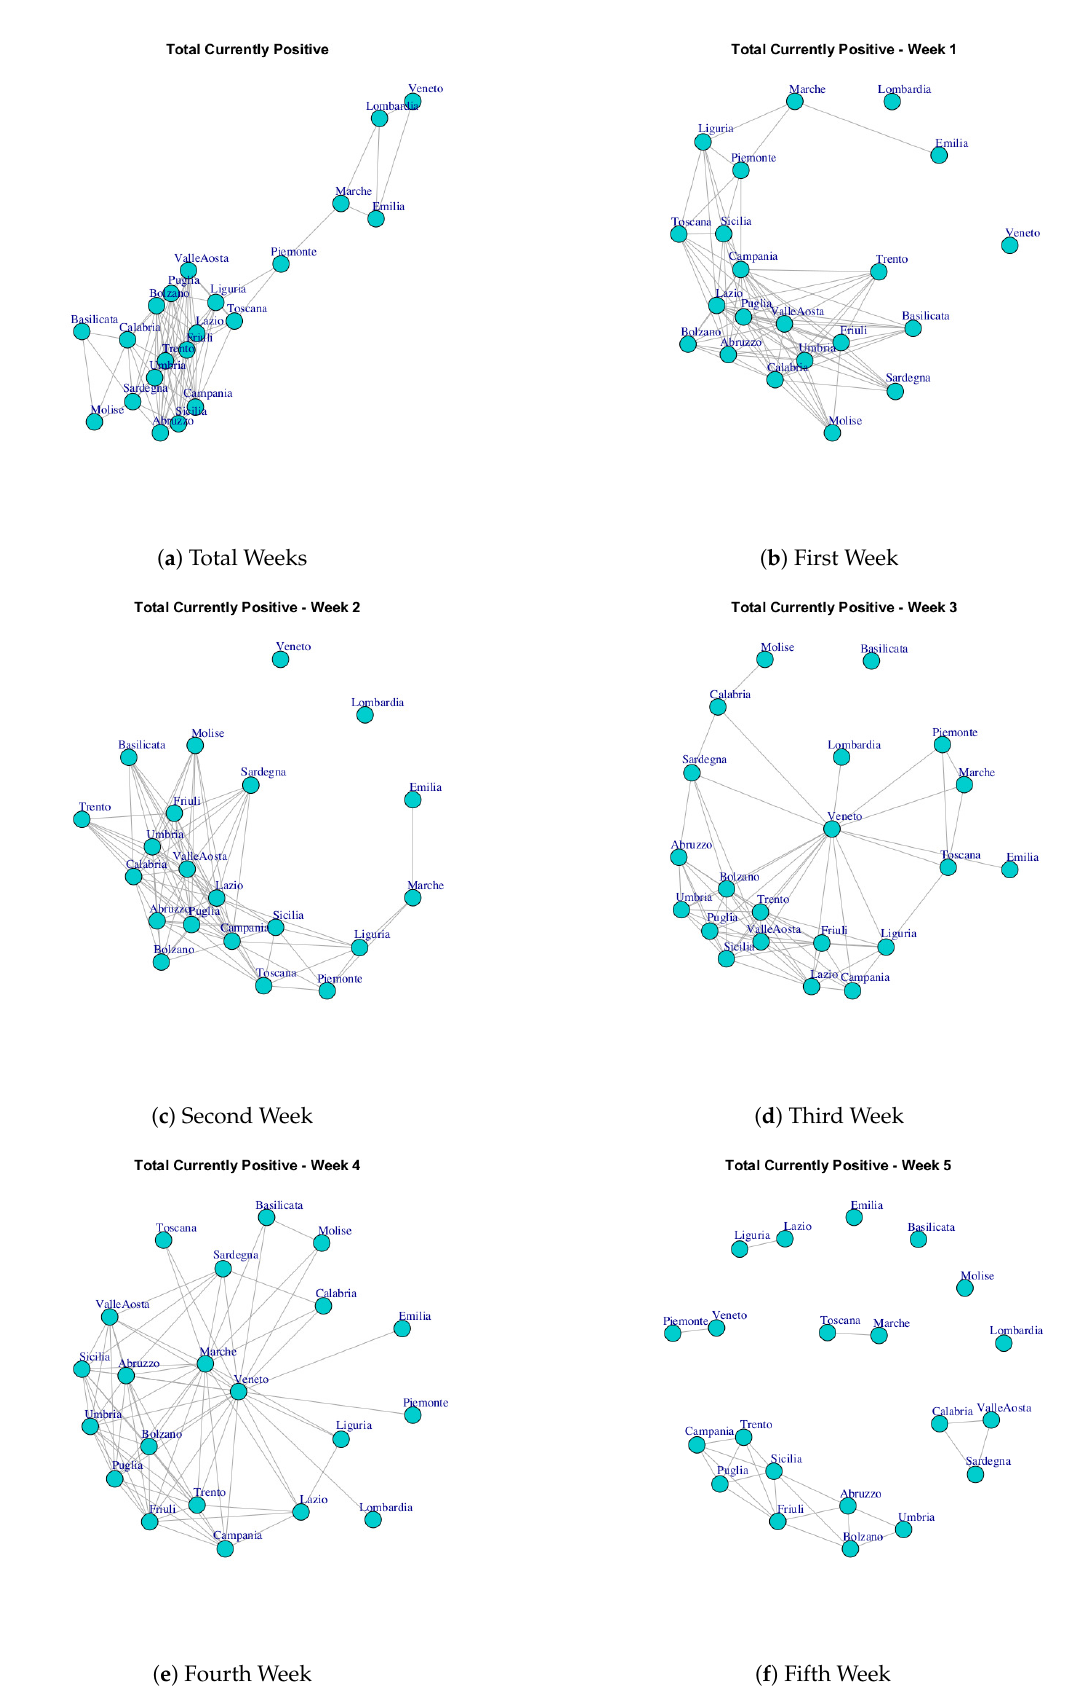
Figure 7. Evolution of Total Currently Positive